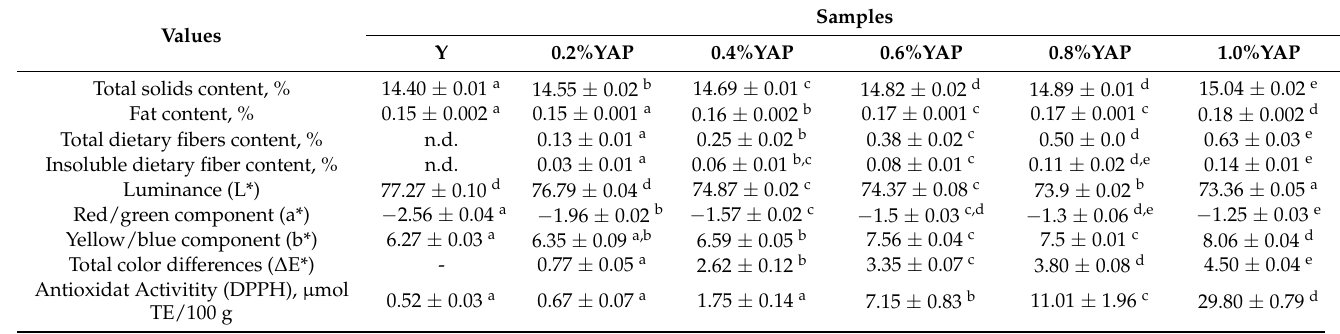
Table 4. Physicochemical, color and antioxidant activity of yogurt with apple pomace